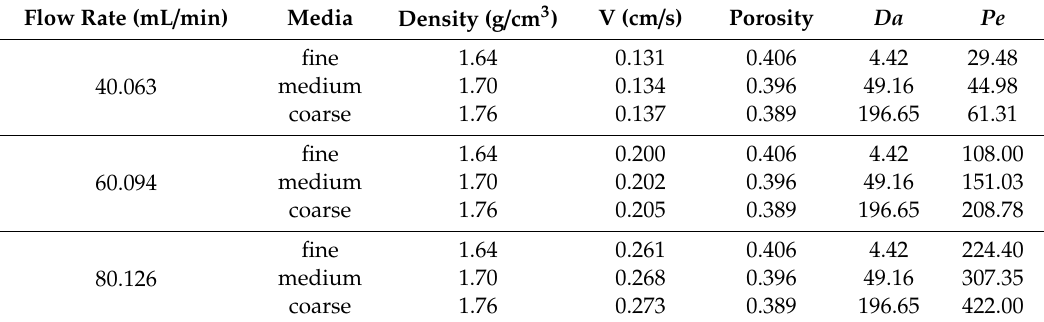
Table 1. Bimolecular reactive migration in porous media.